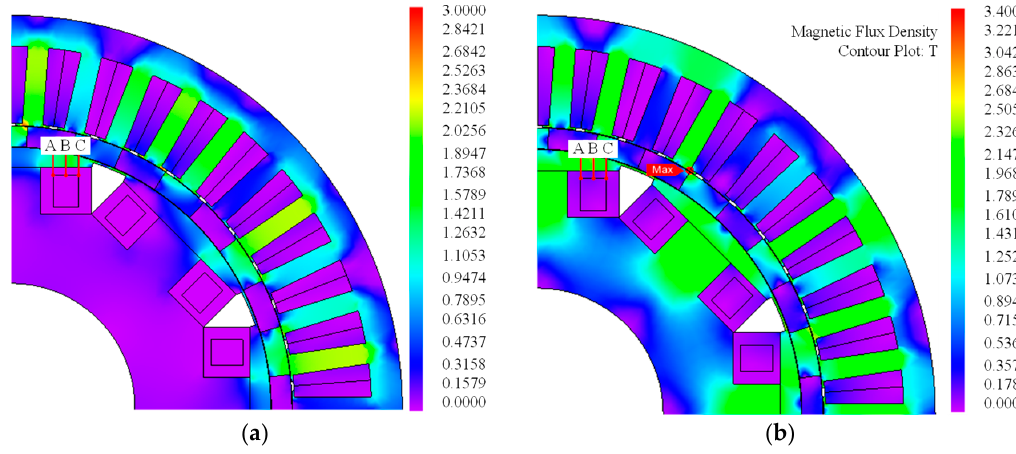
Figure 5. Magnetic flux density contour plot: ( a ) rated load without field-excitation current and ( b ) rated load with rated field-excitation current.